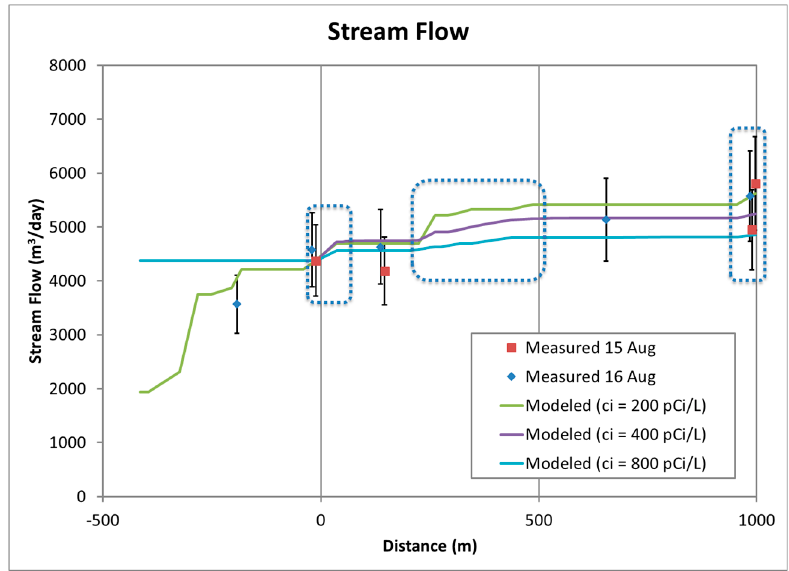
Figure 4. Stream discharge along Martis Creek study area measured with a FP111 flow probe (red squares and blue diamonds). Distance 0 shows the tracer introduction location (MC00, Table 1). Vertical error bars are ±15%, based on the typical reproducibility of low flow measurements. Modeled groundwater influx over the study reach is also shown for different values of the groundwater 222 Rn concentration c i (green, purple, and blue lines). Dashed rectangles highlight stretches of Martis Creek where groundwater inflow is detected.